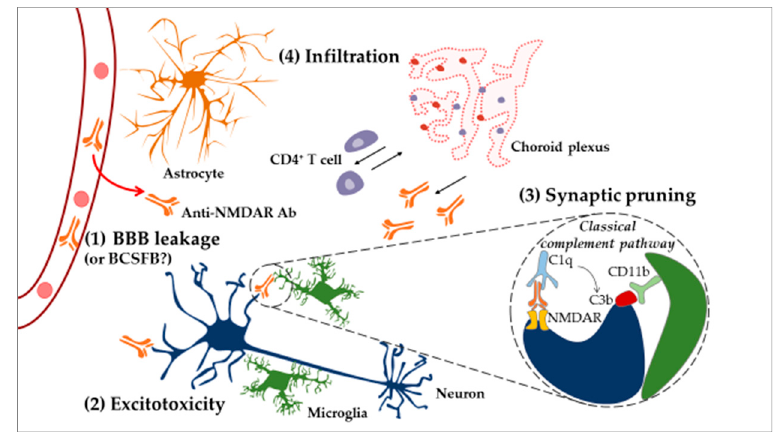
Figure 4. Neuroinflammatory model of NPSLE. In the CNS, under normal physiological conditions, microglial cells act as resident immune cells of the CNS and notably eliminate apoptotic cells. Systemic inflammation renders the BBB permeable to circulating inflammatory factors, for example, certain cytokines and autoAbs (e.g., anti-NMDAR) ( 1 ). After penetration into the brain, anti-NMDAR Abs can induce apoptotic death of neurons through the process of “excitotoxicity” ( 2 ). On the other hand, microglial cells can eliminate dendritic spines (the anatomical location of synapses) through a mechanism called “synaptic pruning” ( 3 ). Hypothetically, anti-neuronal autoAbs bind neuronal antigens recognized by the complement factor C1q (synthetized by the CNS), leading to the production of C3b. Dendritic processes displaying C3b are recognized and phagocytosed by microglia. Furthermore, CNS cells activated following BBB’s leakage upregulate ICAM-1 and VCAM-1 and modulate cytokine expression, resulting in the recruitment of peripheral immune cells ( 4 ). CD4 + T cells infiltrate the CP and the brain parenchyma, while CD19 + B cells are only found in the CP. This suggests that CD4 + T cells might sample the brain environment in the parenchyma and activate CD19 + B cells in the CP, leading to the production of Abs that circulate into the CSF. Abbreviations: Ab, antibody; BBB, blood–brain barrier; BCSFB, blood–cerebrospinal-fluid barrier; CNS, central nervous system; CP, choroid plexus; CSF, cerebrospinal fluid; ICAM-1, intercellular adhesion molecule-1; NMDAR, N-methyl- D -aspartate receptor; VCAM, vascular cell adhesion protein 1.